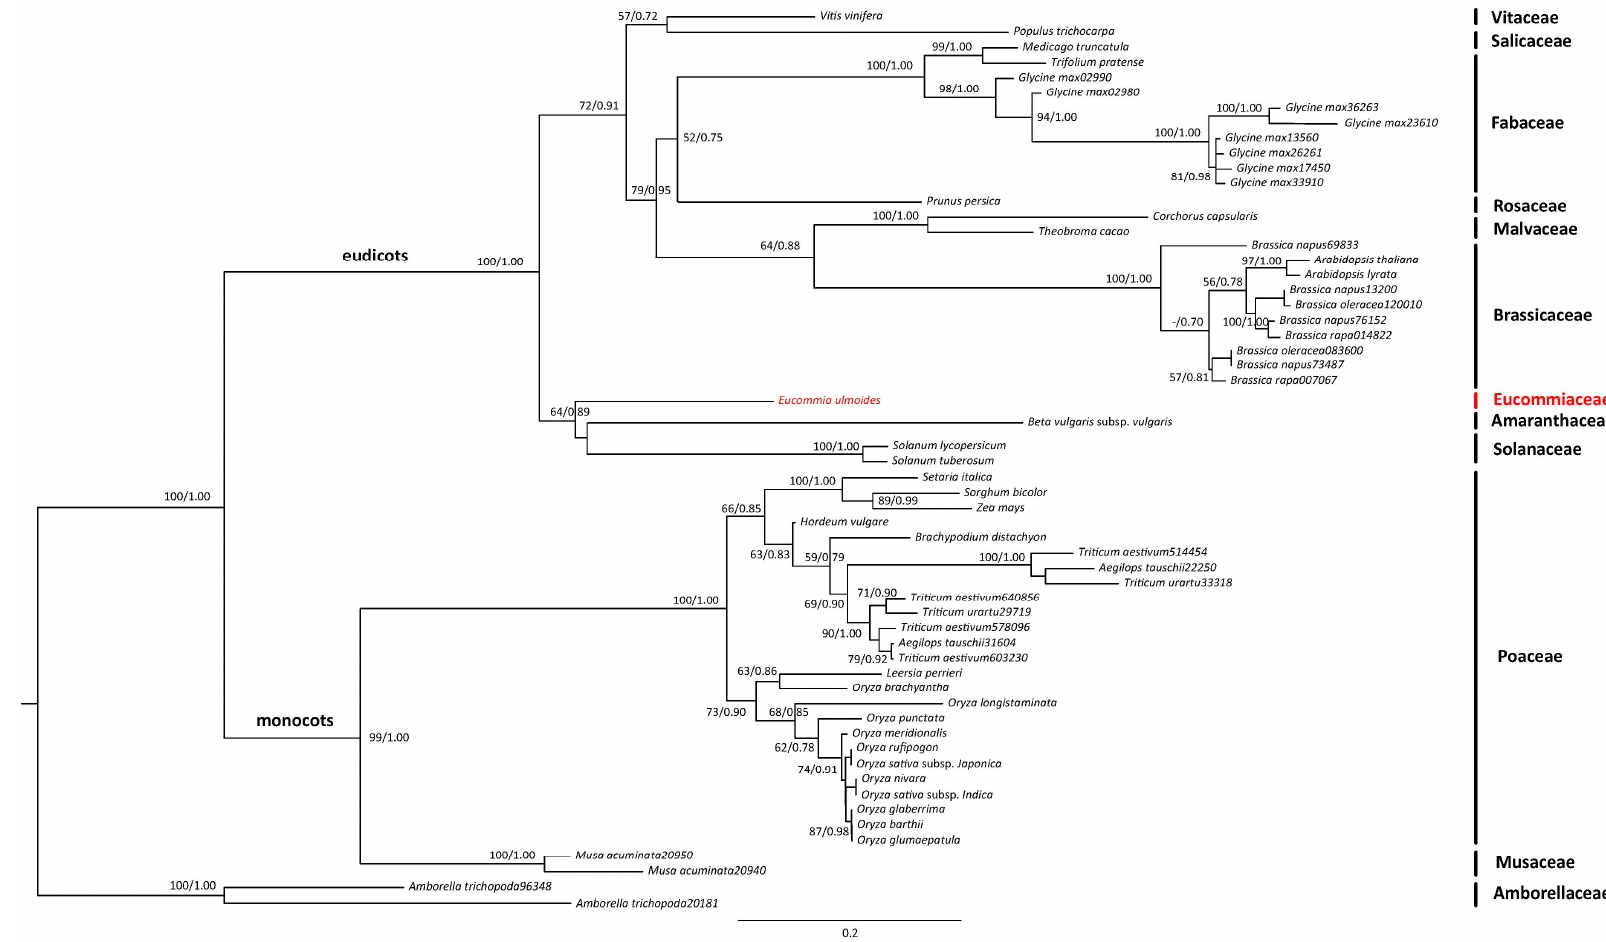
Figure 6. The maximum-likelihood phylogenetic tree constructed using 58 AP3 orthologous sequences in 38 angiosperms. Eucommia ulmoides are colored in red, and the numbers above the nodes represent the support values (MLBP/PP). The numbers after the species name indicate different gene copies .